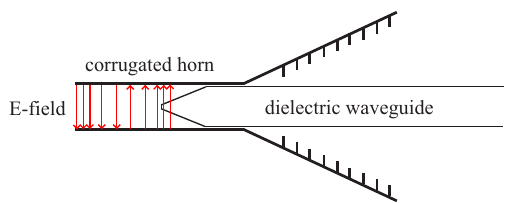
Figure 18. Schematic drawing of the transition from waveguide to dielectric